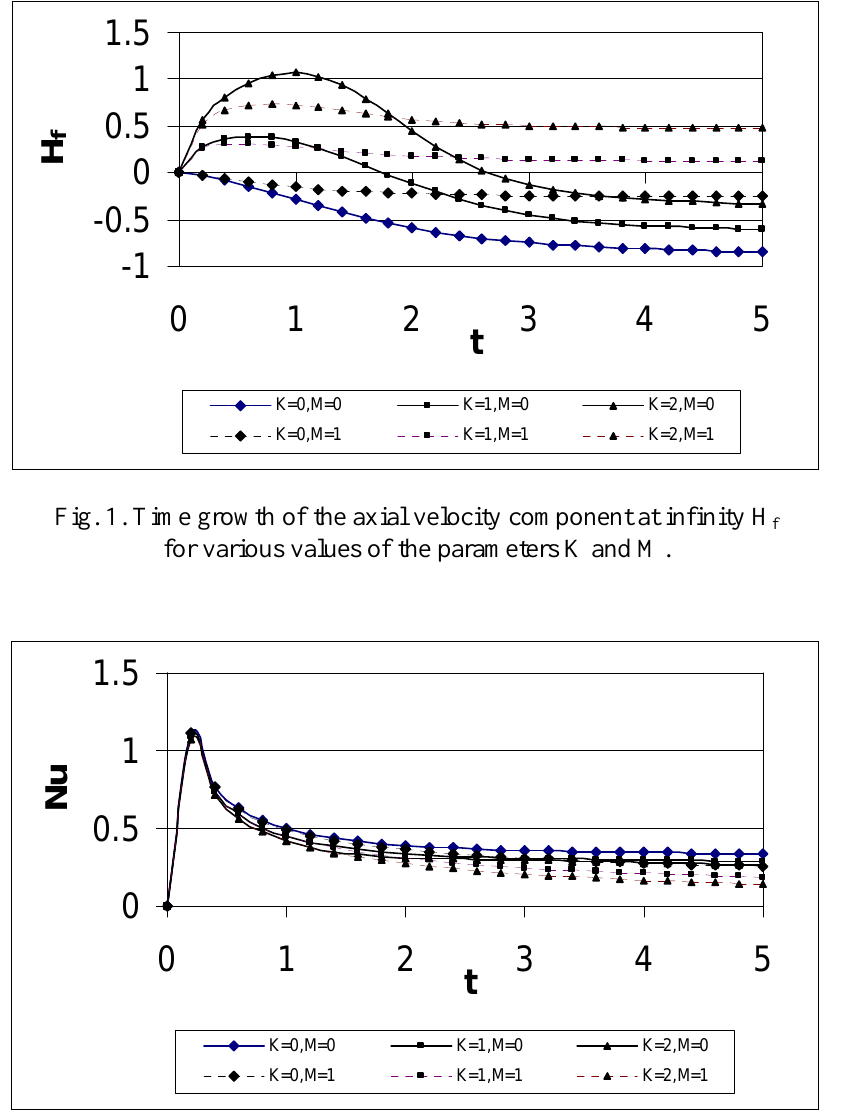
Fig. 2. Time growth of the Nusselt number at the surface of the disk for various values of the parameters K and M.